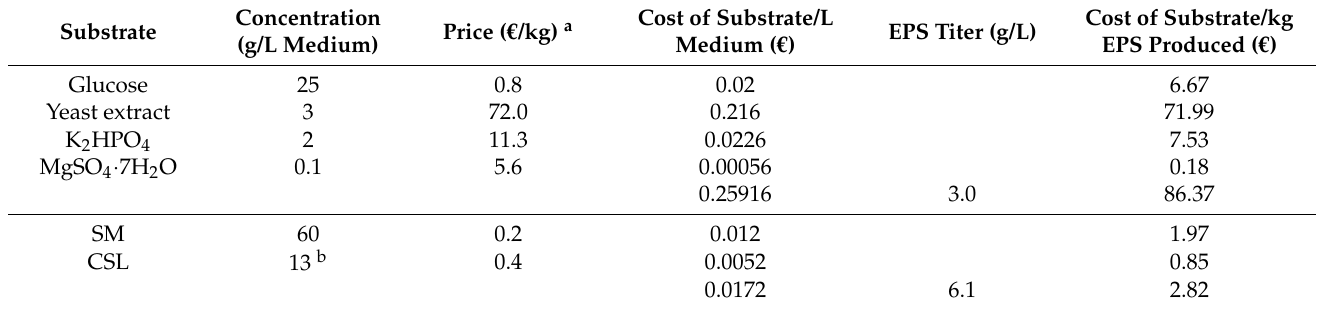
Table 4. Economic analysis for the cost of the substrates used for exopolysaccharide production by Rhizobium viscosum